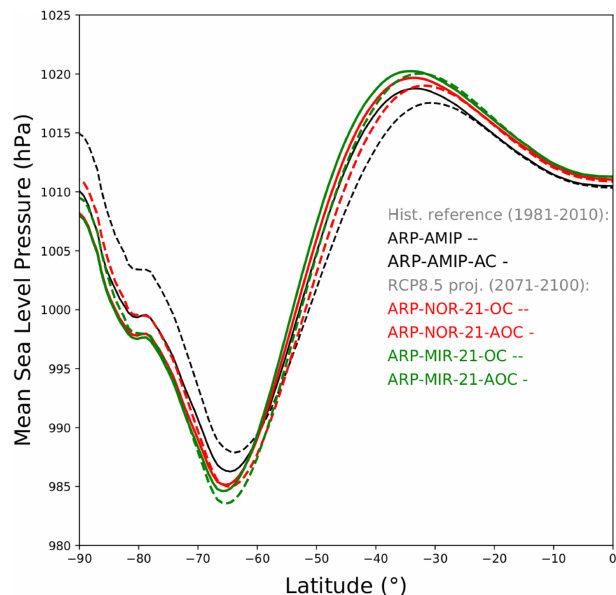
Figure 7. Yearly mean sea-level pressure (hPa) for ARPEGE histor- ical simulation (1981–2010) and RCP8.5 projections (2071–2100). Uncorrected control runs are displayed in dashed lines and runs with atmospheric bias correction are presented in plain lines. Histori- cal simulations realized with observed SSCs are displayed in black (ARP-AMIP-AC) or gray (AMIP). Future projections (RCP8.5) driven by bias-corrected SSCs from NorESM1-M (MIROC-ESM) are shown in red